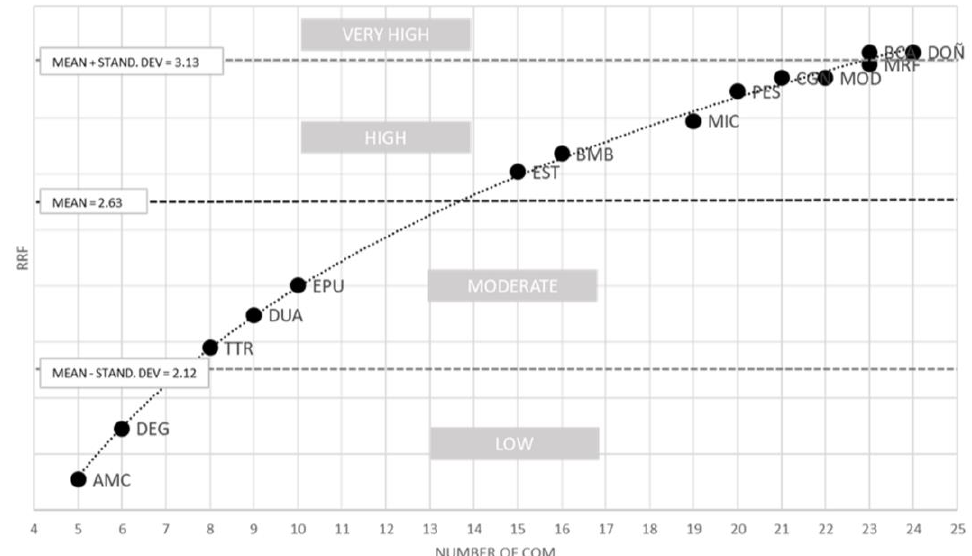
Figure 2. Ranking from the lowest to the highest rarefaction (RRF) value and number of communities in the Protected Areas. AMC, Acantilados de Maro-Cerro Gordo; BCA, Bahía de Cádiz; BMB, La Breña y Marismas de Barbate; CGN, Cabo de Gata-Níjar; DEG, Desembocadura de Guadalhorce; DOÑ, Doñana; DUA, Dunas de Artola; EPU, Enebrales de Punta Umbría; EST, Estrecho; MIC, Marismas de Isla Cristina; MOD, Marismas del Odiel; MRF, Marismas del Río Piedras y Flecha del Rompido; PES, Punta Entinas-Sabinar; TTR, Tómbolo de Trafalgar.